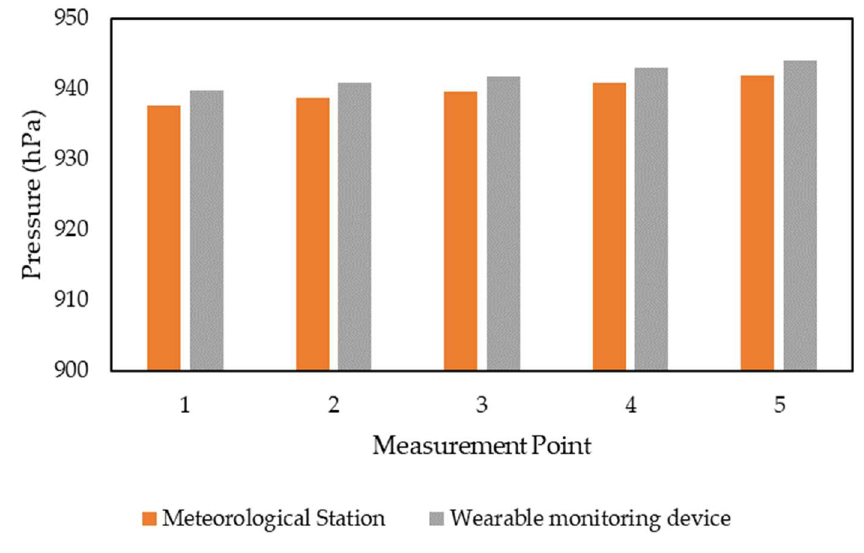
Figure 4. Pressure measurements comparison at points (1 to 5).